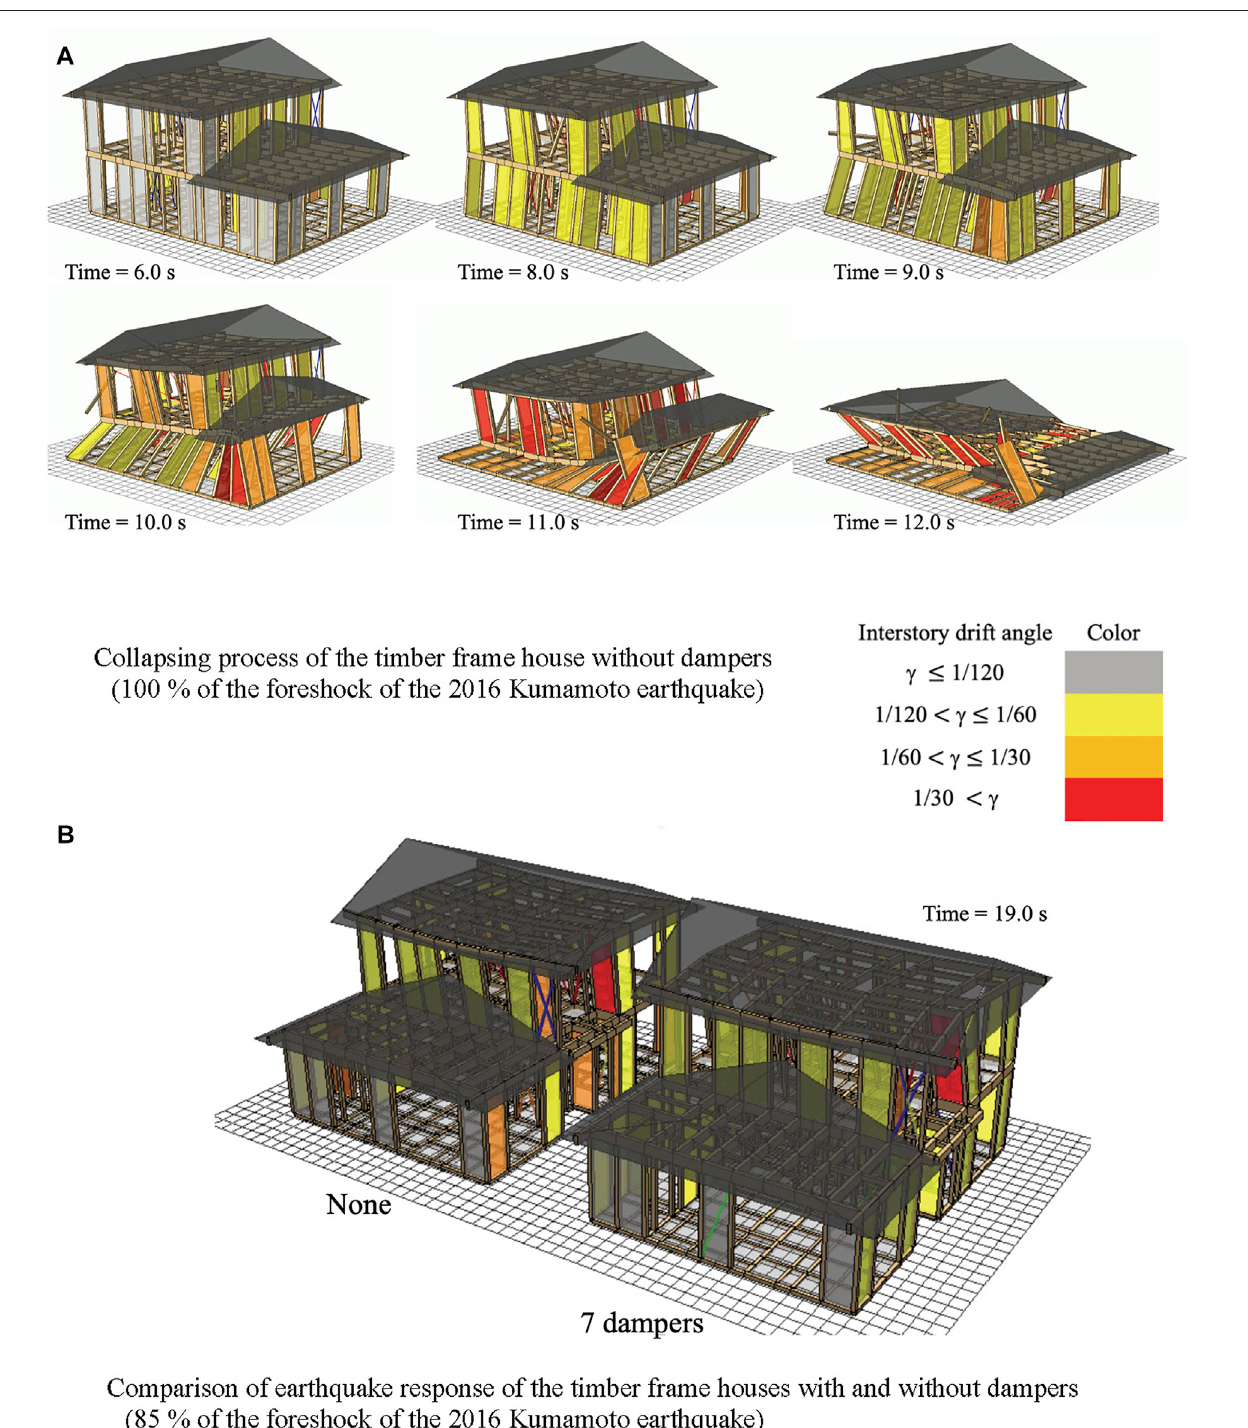
FIGURE 10 | 3D pictures of earthquake response analyses of the timber frame house. (A) Collapsing process of the timber frame house without dampers(100 % of the foreshock of the 2016 Kumamoto earthquake). (B) Comparison of earthquake response of the timber frame houses with and without dampers.